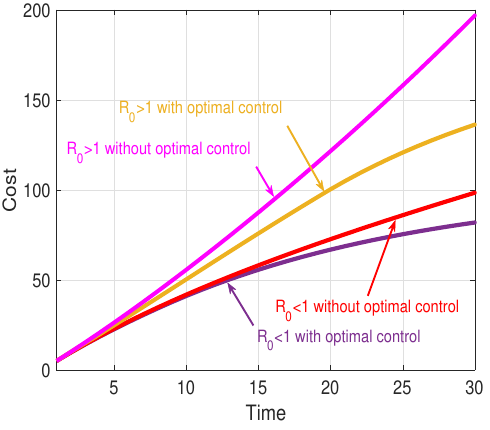
Figure 8. Overall